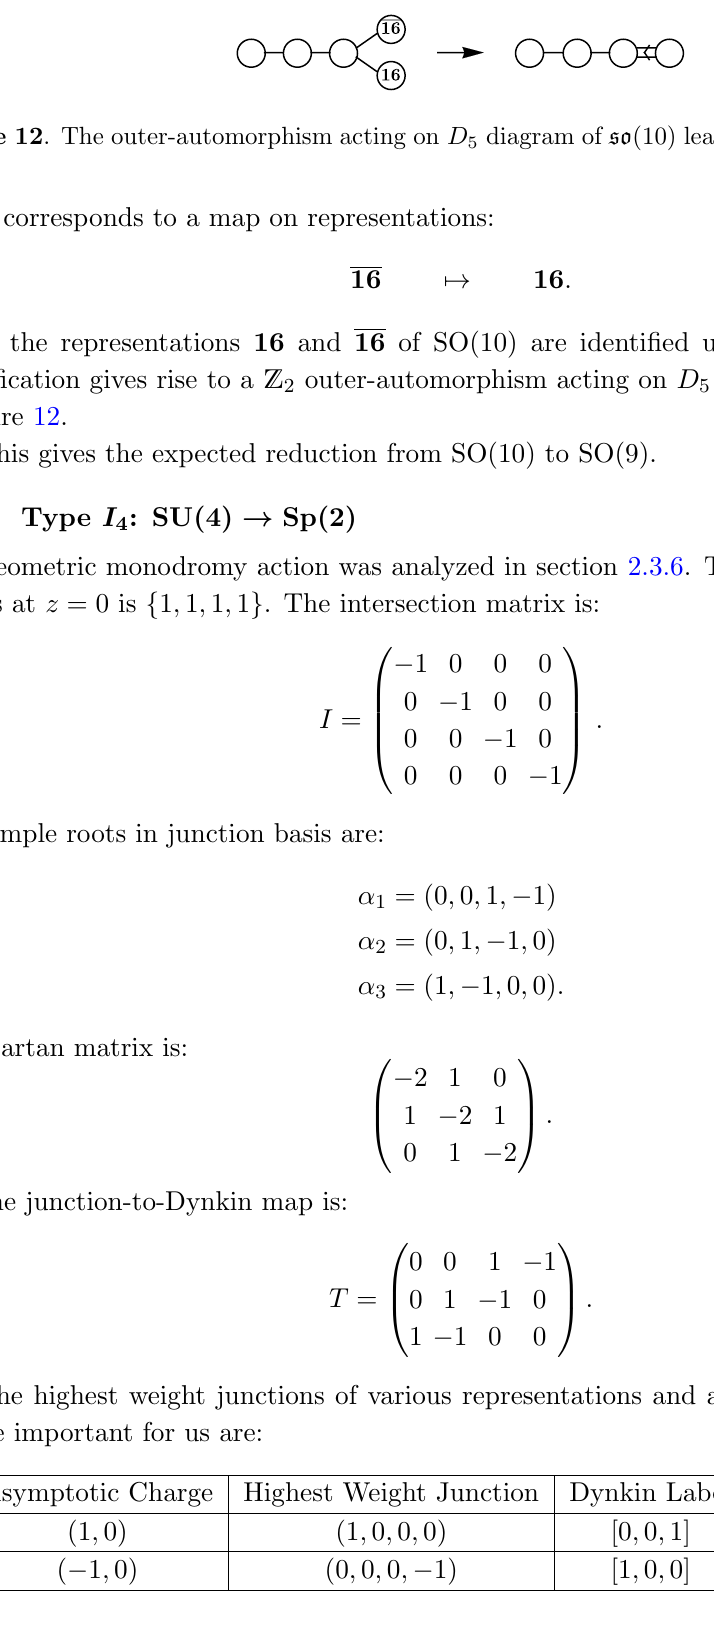
Figure 12 . The outer-automorphism acting on D 5 diagram of so (10) leads to B 4 diagram of so (9). which corresponds to a map on